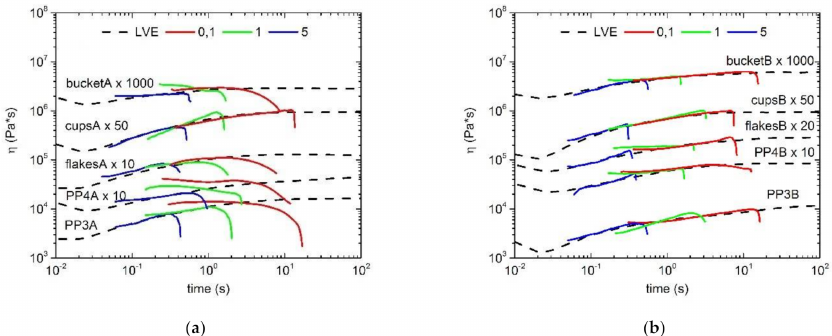
Figure 6. Extensional rheology of all curves for the virgin materials ( a ) and with the PP2 blends series ( b ).